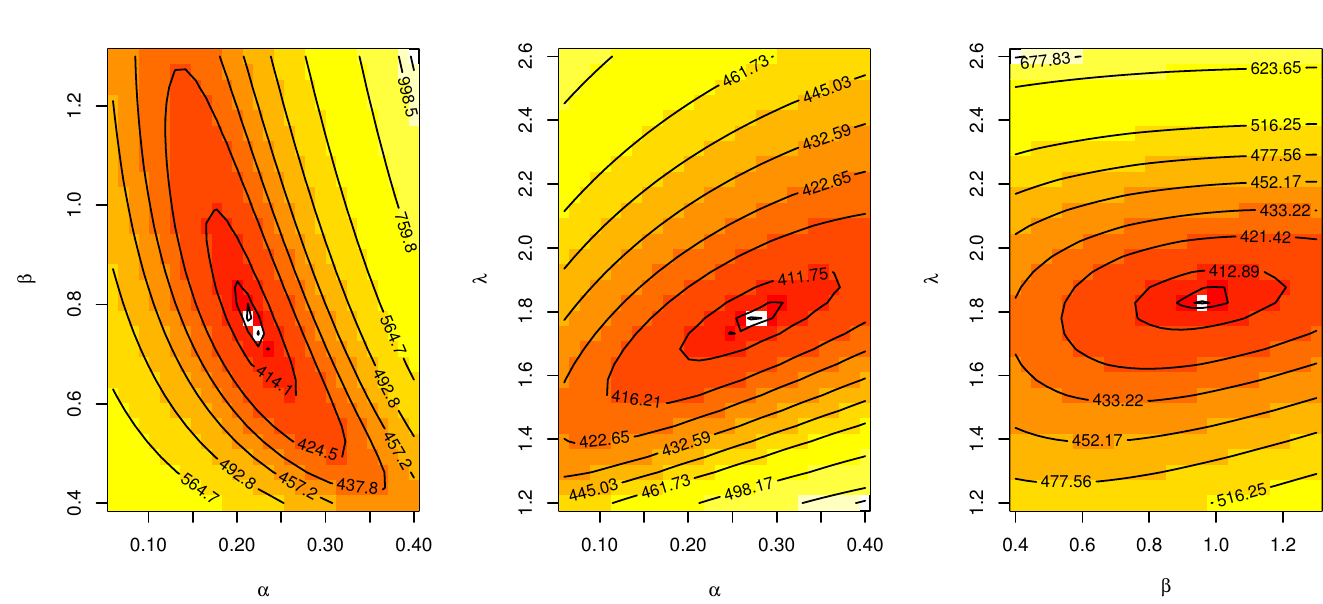
Figure 4. Contour plot of parameters and log-likelihood value for the TIIHLW